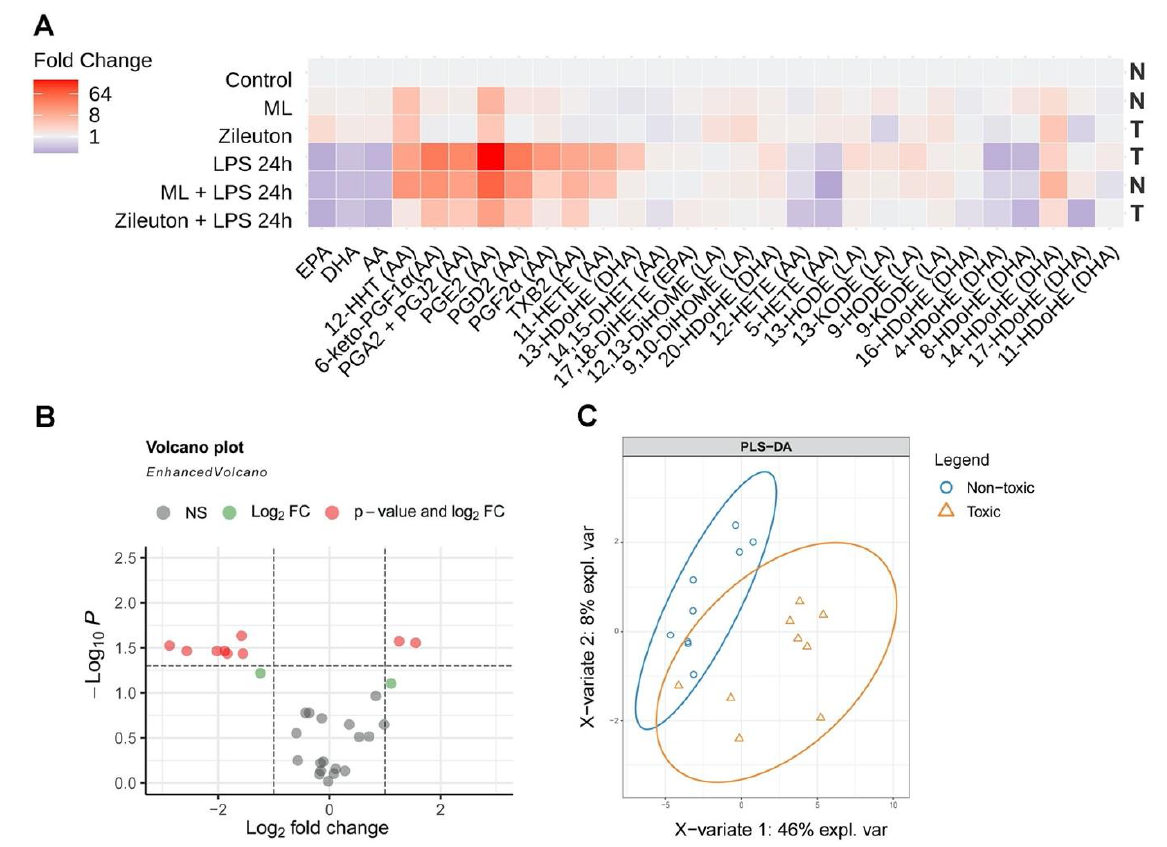
Figure 4. ML355 and Zileuton modulate oxylipin profiles of the LPS-stimulated astrocytes. The primary rat astrocyte cultures were pretreated with Zileuton (10 µ M) or ML355 (10 µ M) for 30 min and then stimulated with LPS (100 ng/mL) for 24 h. The concentrations of oxylipins in the supernatants were measured using ultra-performance liquid chromatography- tandem mass spectrometry (UPLC-MS/MS). ( A ) The heat map shows the relative amounts of each lipid mediator, compared to the control. The vertical axis indicates the stimuli, while the horizontal axis indicates each lipid mediator’s relative amount (log2), N—non-toxic fraction and T—toxic fraction. ( B ) The volcano plot indicates significantly changed compounds. The X -axis indicates a log2 fold change of toxic fractions. The Y -axis indicates log10 p -values (adjusted). The cut-off for p -values is indicated, based on Bonferroni correction. Compounds that changed insignificantly are indicated in gray, and compounds, the means of which changed in toxic fractions (relative to neuroprotective fractions) more than twofold or less than twofold but insignificantly, are indicated in green. Red dots stand for compounds which changed more than twofold and had a p -value (adjusted < 0.05). ( C ) The partial least square discriminant analysis (PLS-DA) model discriminates toxic (T) and non-toxic (N) for neuron fractions. The explained variance of each component is indicated in brackets on the corresponding axis.